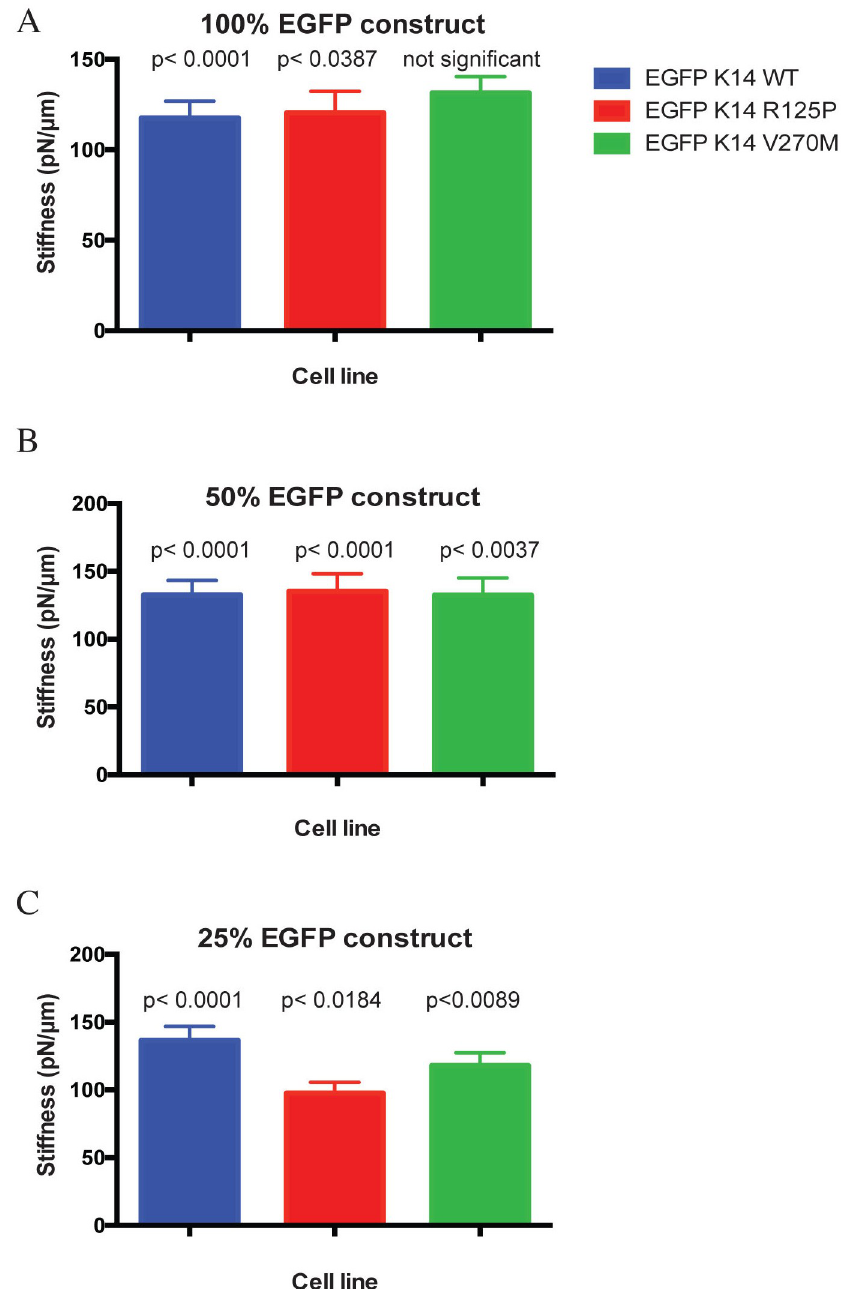
Fig 5. Correlation between cell stiffness and the expression rate of the EGFP-K14 constructs. Graphs depict how the expression rates of the EGFP-K14 constructs affect cell stiffness in different EGFP-K14 cell lines. All 100% EGFP-K14 cell lines (A) and 50% EGFP-K14 cell lines (B) do not display any major difference in cell stiffness. In striking contrast to this, there is a significant difference in cell stiffness between the 25% EGFP-K14 cell lines (C). In particular, the 25% EGFP-K14 R125P cells are on average 30% softer than the corresponding control 25% EGFP-K14 WT cells.